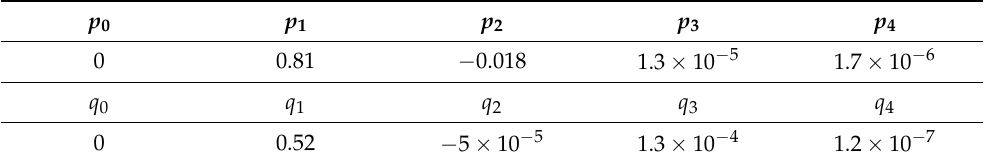
Table 4. Spline Path Parameter